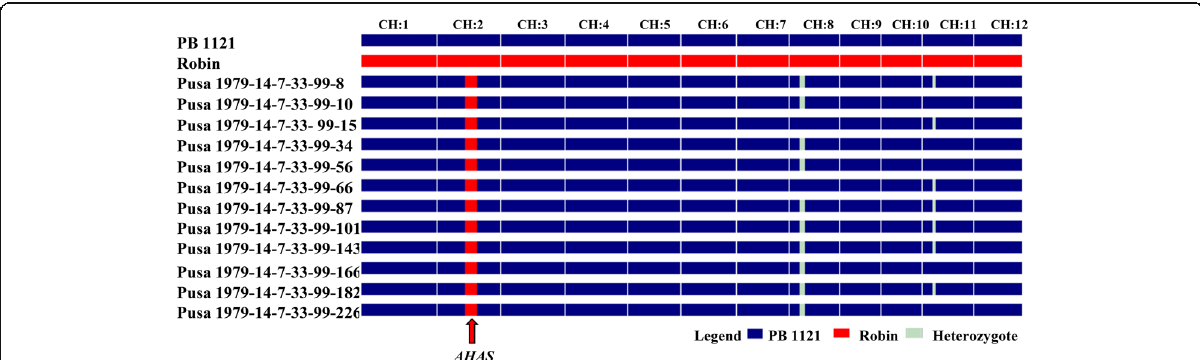
Fig. 3 Graphical representation of PB 1121 HT-NILs carrying mutant AHAS gene showing the extent of recurrent parent genome (RPG) recovery.